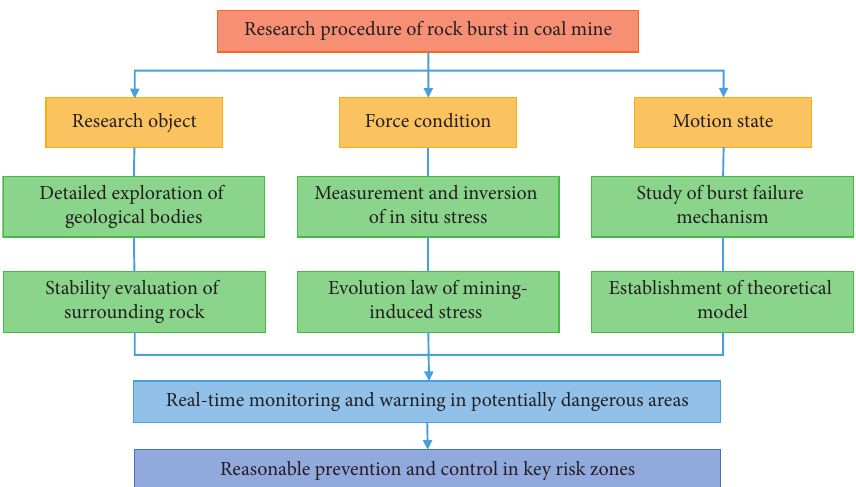
Figure 3: Research procedure of rock burst involving the three elements of Newton’s second